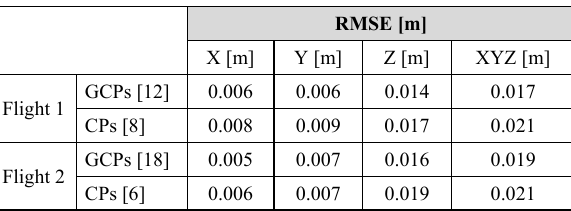
Table 2. Metric Control of UAV